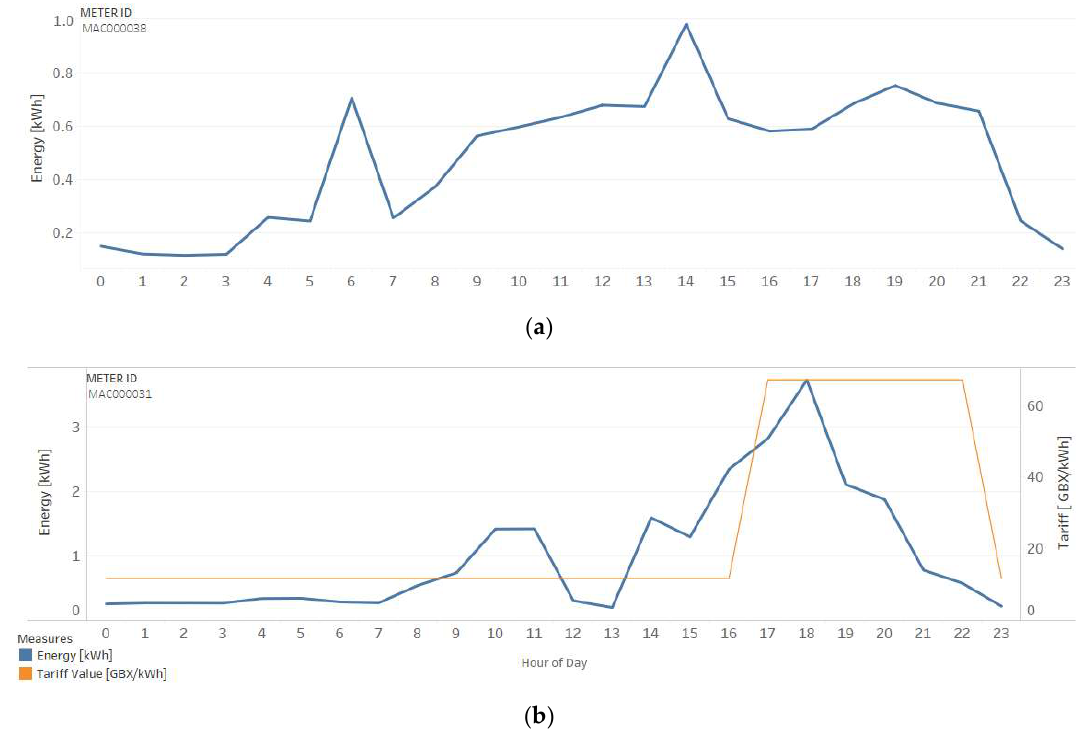
Figure 7. Household energy consumption: ( a ) metering with a standard tariff and ( b ) metering with a dynamic time of use.